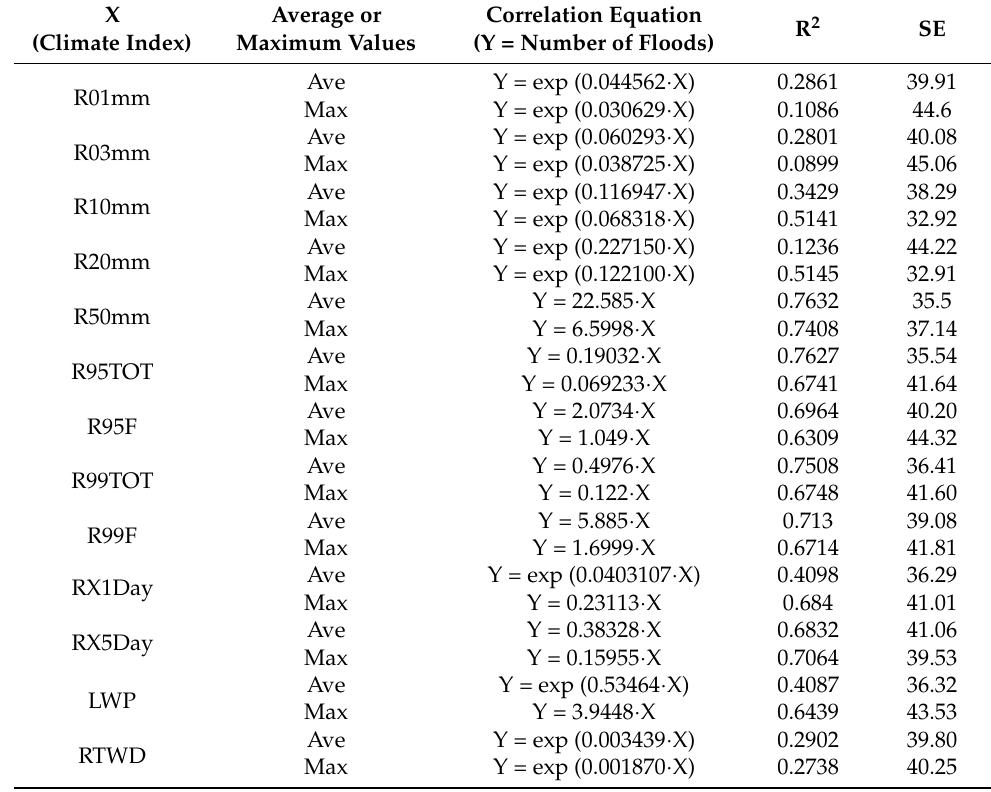
the annual number of floods occurred in